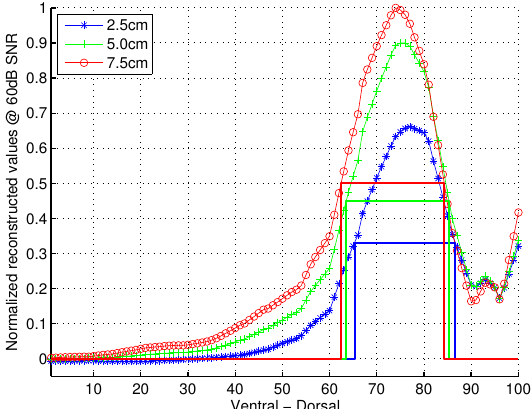
Fig.10: The normalized edema reconstructions along the ventral to dorsal oriented line passing through the peak value of the reconstructions